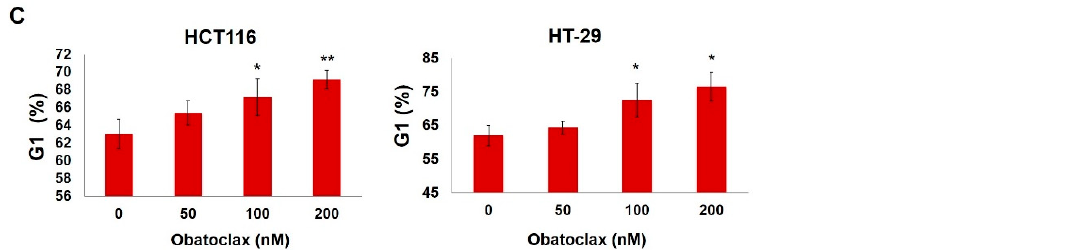
Figure 1. Antiproliferative action of obatoclax on a panel of human colorectal cancer cell lines. ( A ) Obatoclax inhibits colorectal cancer cell proliferation. Human colorectal carcinoma cell lines HCT116, HT-29, and LoVo cells (4 × 10 4 ) were treated with obatoclax (0, 50, 100, 200 nM) for 24, 48, and 72 h. The numbers of cells at each time point were counted using a Neubauer chamber. Data were presented as the percentage relative to the drug-untreated control; ( B ) Obatoclax suppresses colony formation by colorectal cancer cells. ( Upper panel ) HCT116, HT-29, and LoVo cells (2 × 10 2 ) treated with obatoclax (0, 100, 200 nM) for 24 h were allowed to proliferate in drug-free culture media for 10~14 days to form colonies, followed by crystal violet staining for scoring colonies. Shown here are the representative images from three independent experiments. ( Lower panel ) Quantitative results of the upper panels. Data were presented as the percentage relative to the drug-untreated control; ( C ) Obatoclax arrests cell cycle progression at the G 1 -phase. HCT116 and HT-29 cells were treated with obatoclax (0, 50, 100, 200 nM) for 24 h, followed by flow cytometry analyses to determine the levels of cell population at the G 1 -phase of the cell cycle. Data were presented as the percentage relative to the drug-untreated control. *: p < 0.05; **: p < 0.01; ***: p < 0.001.